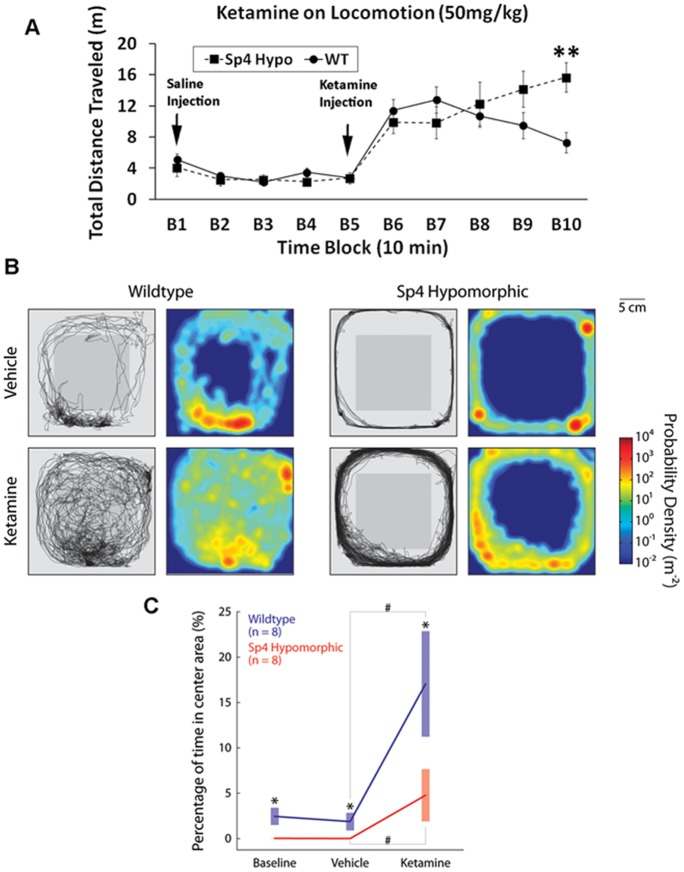
Simultaneous recording of mouse locomotion during EEG recording.(A) After one-hour habituation in EEG recording chamber, mice were treated with saline. Both locomotion and EEG were simultaneously recorded for 50 min after saline injection. Additional 50 minute recording was conducted after ketamine injection. Sp4 hypomorphic (n = 8) mice displayed prolonged ketamine effects in locomotion in comparison with wildtype (n = 8) mice. (B) Differential locomotion patterns between wildtype (left) and Sp4 hypomorphic (right) mice injected with saline and ketamine. (C) Thigmotaxis measured as the percentage of time the animal stayed in the central area of the recording chamber (gray square in B, an area 5 cm away from the edge of the chamber). Asterisks indicate significant differences between the two genotypes and pound signs indicate significant difference between saline vehicle and ketamine injections (2-sample Z-test); error bars represent SEM.